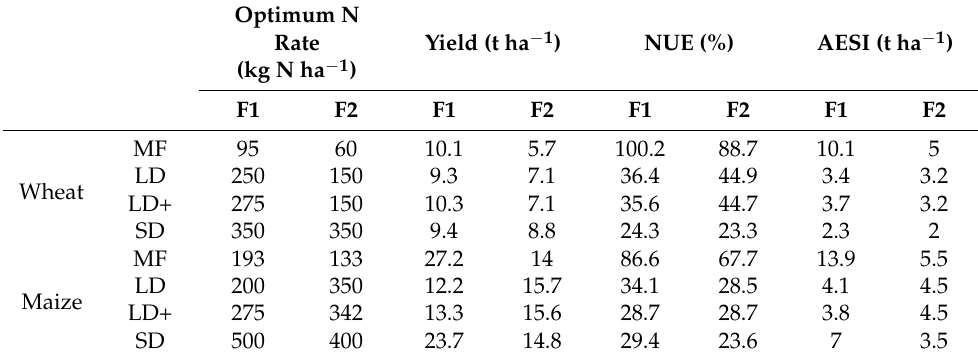
Table 4. The optimum N rate, yield, nitrogen use efficiency (NUE), and agro-environmental sustain- ability index (AESI) results after 9 years (years: 2010-2018) DNDC simulation for both farms (F1 and F2) and crops (winter wheat and maize). MF: mineral fertilizer; LD: liquid digestate fraction; LD+: liquid digestate fraction with nitrification inhibitor; and SD: solid digestate